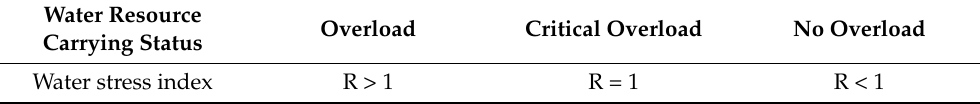
Table 3. Evaluation criteria for control index of water resources carrying capacity in townships.